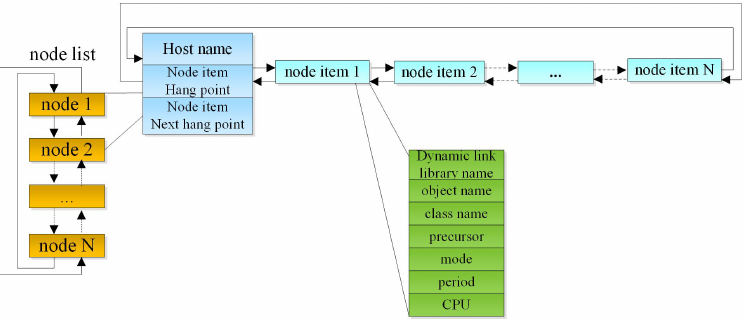
Figure 4. Scheduling management